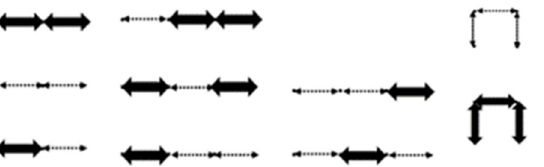
Figure 9. All 10 lattice walks of entry R 2 ( 3, 0 ) of ( R ∗ ) 2 . Variation of arrows represent j = 2 different colored E steps.